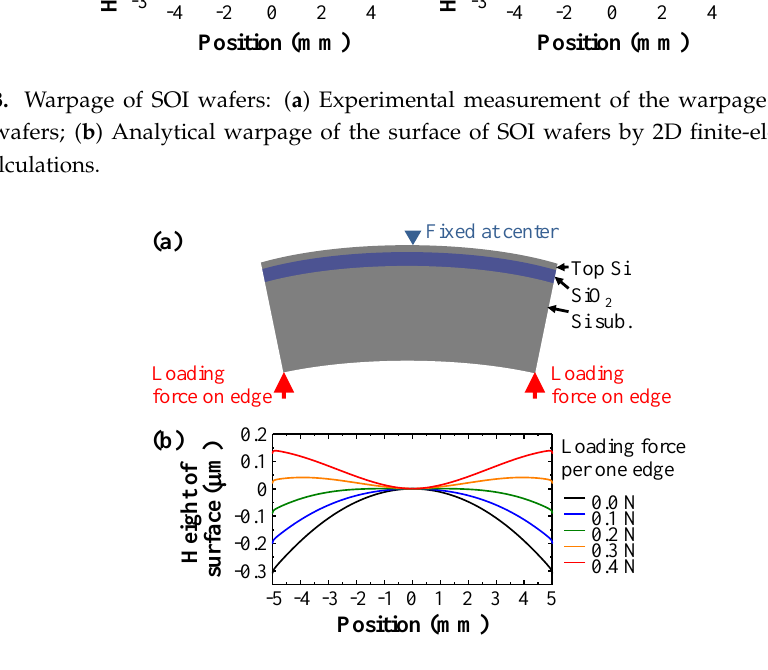
Figure 9. Warpage of SOI wafers with intentional loading force: ( a ) Calculation model; ( b ) Analytical result for wafer A.